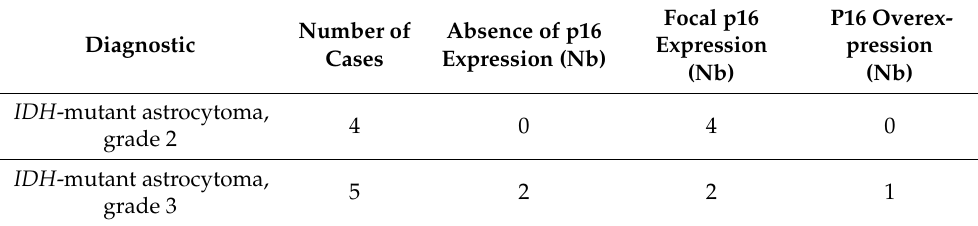
Figure 1. Representative images of patterns of p16 immunohistochemical staining: absence of expression ( A ), focal expression in a variable amount of tumor cells ( B ), and intense and diffuse expression in a large majority of tumor cells ( C ). Scale bar is 50 µm for Figure 1A–C. Table 2. Patterns of p16 expression in the whole cohort.